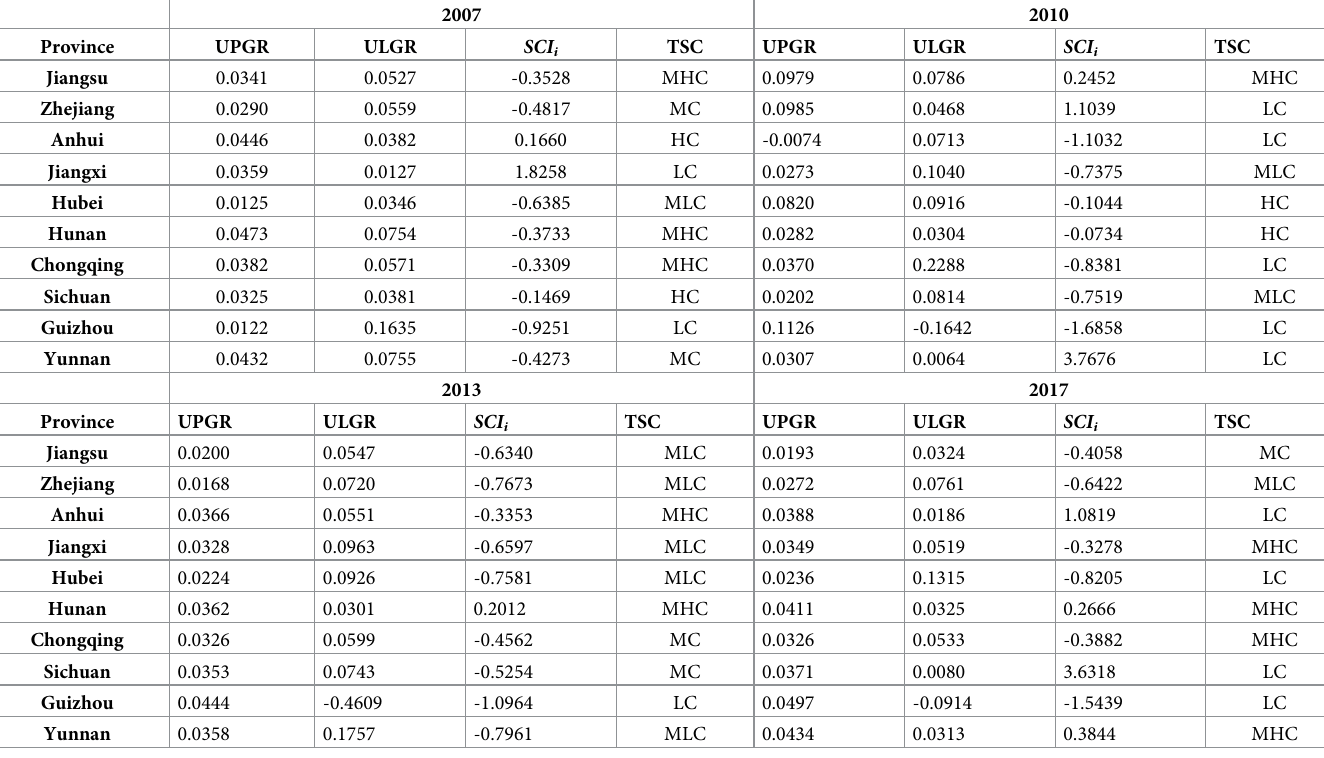
Abbreviations : UPGR represents urban population growth rate, ULGR urban land growth rate, TSC type of speed coordination, LC low coordination, MLC medium- low coordination, MC medium coordination, MHC medium-high coordination, and HC high